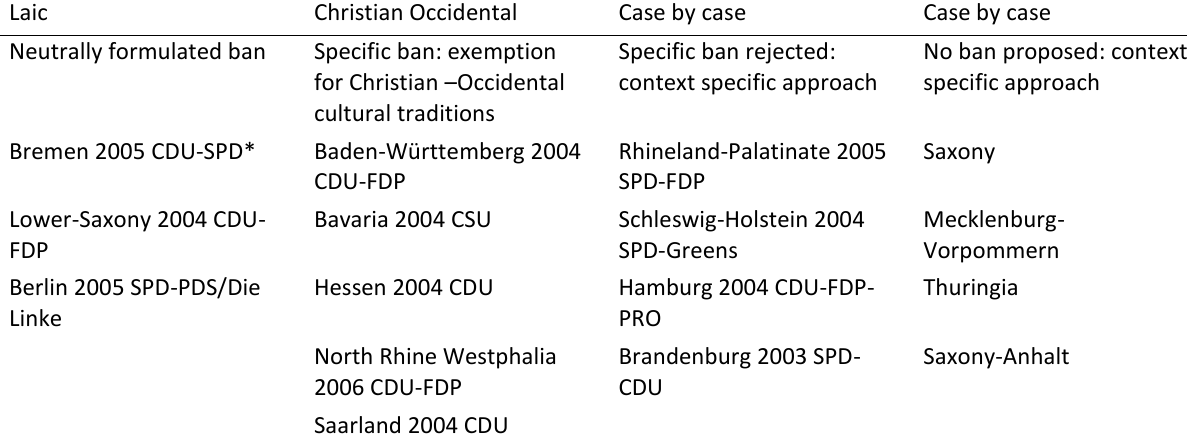
Table 1 . Policy regimes on headscarves in Germany (from: Lettinga, 2011).